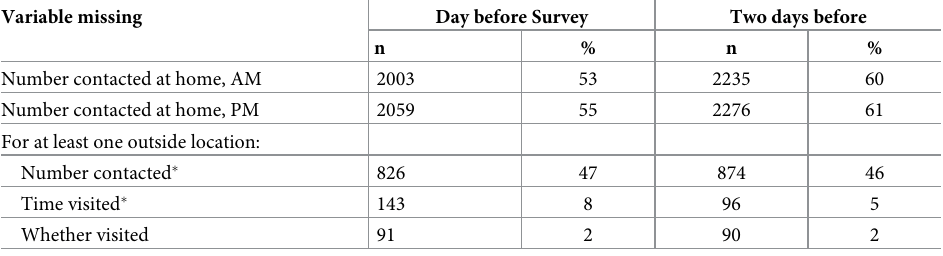
Table 2. Numbers and percentages of participants missing data contributing to the degree calculation. Variable